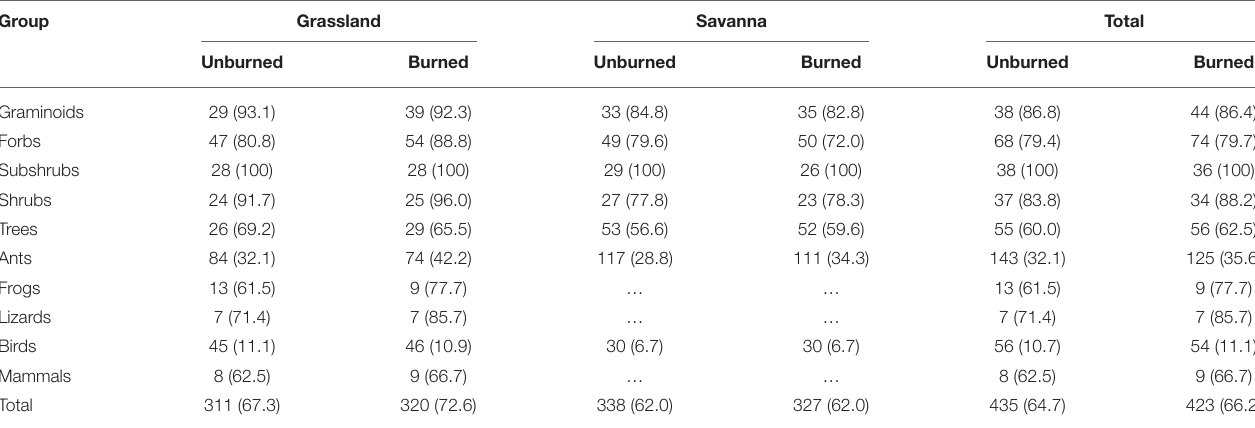
TABLE 1 | Number of species recorded, for each group of plants and animals, in each vegetation type (grassland or savanna) in burned and unburned areas, at Santa Bárbara Ecological Station, state of São Paulo, Brazil. Group Grassland Savanna Unburned